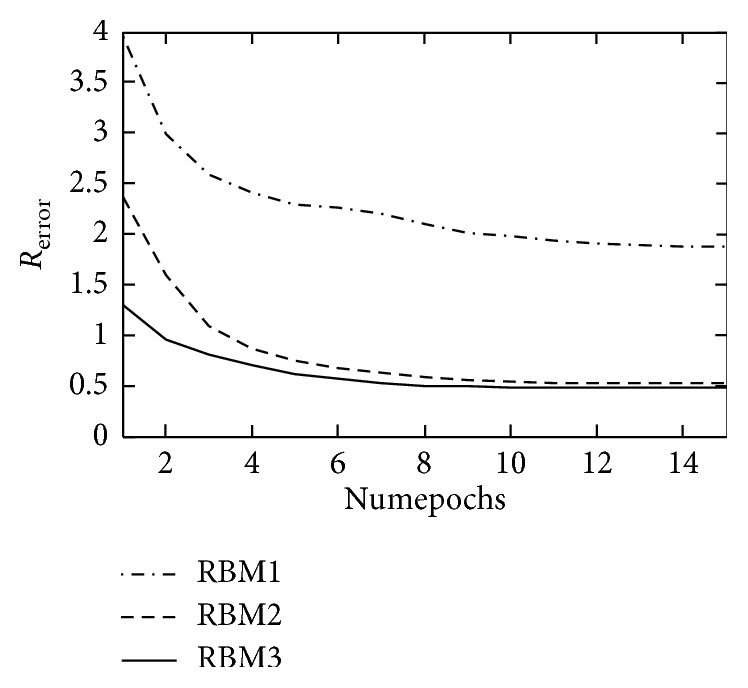
The Rerror curve of each layer RBM on Statlog (Heart).